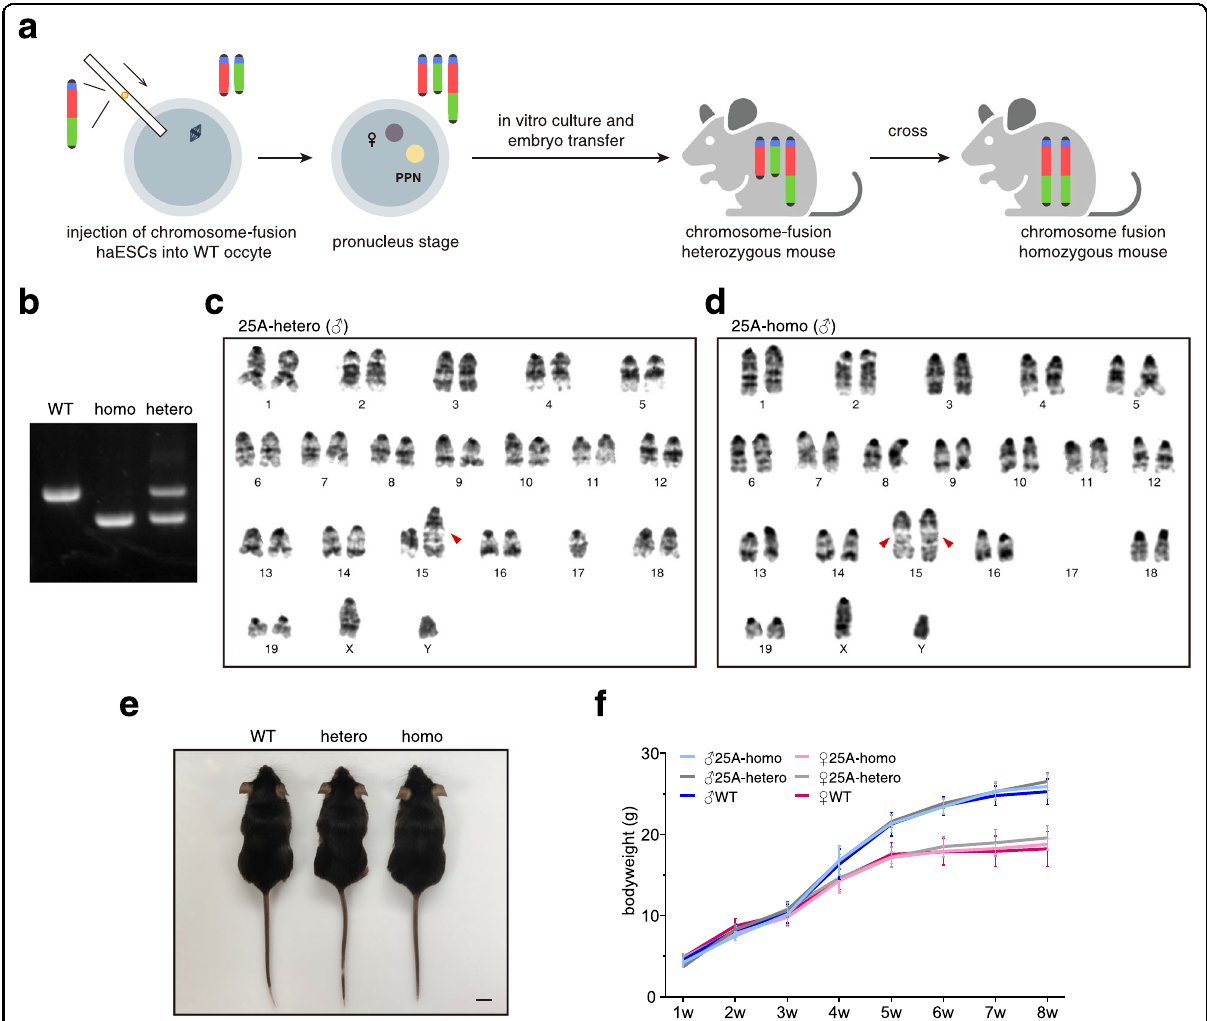
Fig. 4 Generation of chromosome fusion mice. a Schematic procedures showing the generation of chromosome-fusion heterozygous mice (see Methods). Chromosome-fusion homozygous mice are generated by crossing between heterozygous female and male mice. PPN (pseudo- pronucleus) was derived from the injected haESCs. b Genotype analysis of the chromosome fusion homozygous and heterozygous mice. WT and homozygous mice showed a ~860 bp and a ~660 bp band, respectively, while heterozygous mouse showed both. c G-band karyotype analysis of 25A heterozygous male mouse (37 + XY, t(15;17)(F3;A2)). The red arrowhead indicates the fused Chr15-17. d G-band karyotype analysis of 25A homozygous male mouse (36 + XY, t(15;17)(F3;A2)×2). The red arrowhead indicates the fused Chr15-17. e The appearances of a WT male mouse